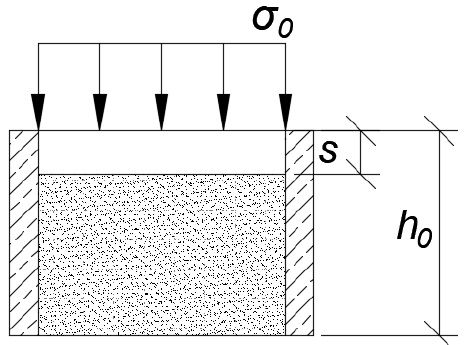
Figure 1. Scheme of confined compression as in oedometer test; σ 0 , compressive load on the soil sample (kPa); s , settlement of the soil sample (m); h 0 , primary thickness of soil sample (m).